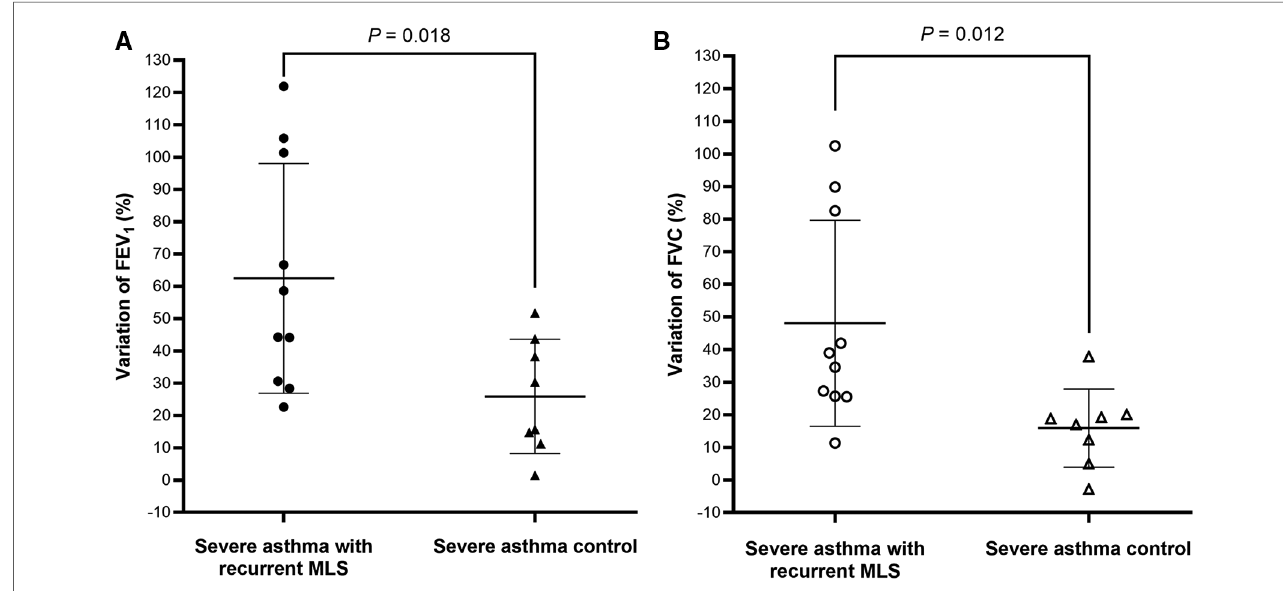
FIGURE 2 FEV 1 (A) and FVC (B) variations between acute and stable stages are plotted for children with severe asthma with recurrent MLS vs. severe asthma controls. Bar charts represented mean±standard deviation. FEV 1 : forced expiratory volume in 1 s; FVC: forced vital capacity; MLS: middle lobe